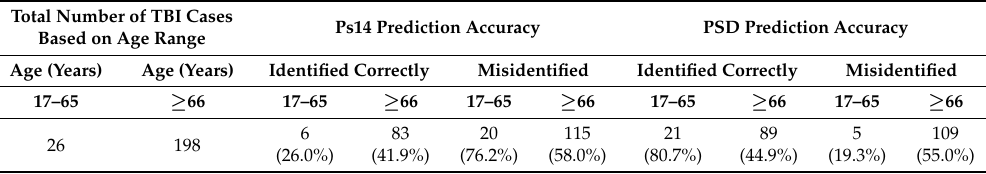
Figure 9. The number of cases in the validation set correctly identified by Ps14 and PSD ( a ) non-surviving cases; ( b ) surviving cases. The middle bar indicates the overlap in correct identification of cases by both Ps14 and PSD. Table 8. Performance comparison of PSD and Ps14 based on age groups for cases in the validation dataset that had not